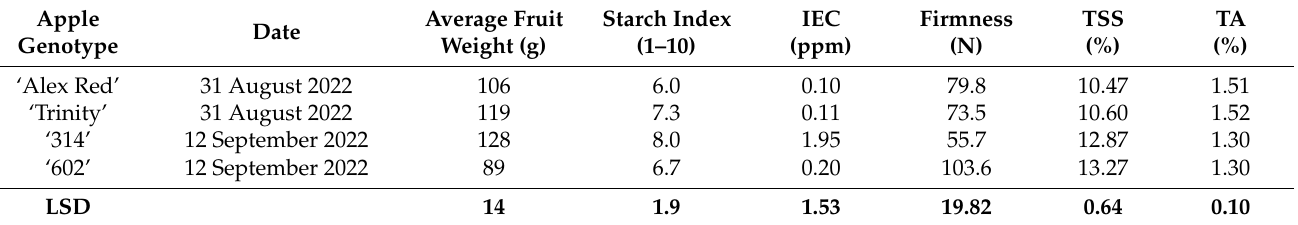
Table 1. Fruit quality at harvest time in